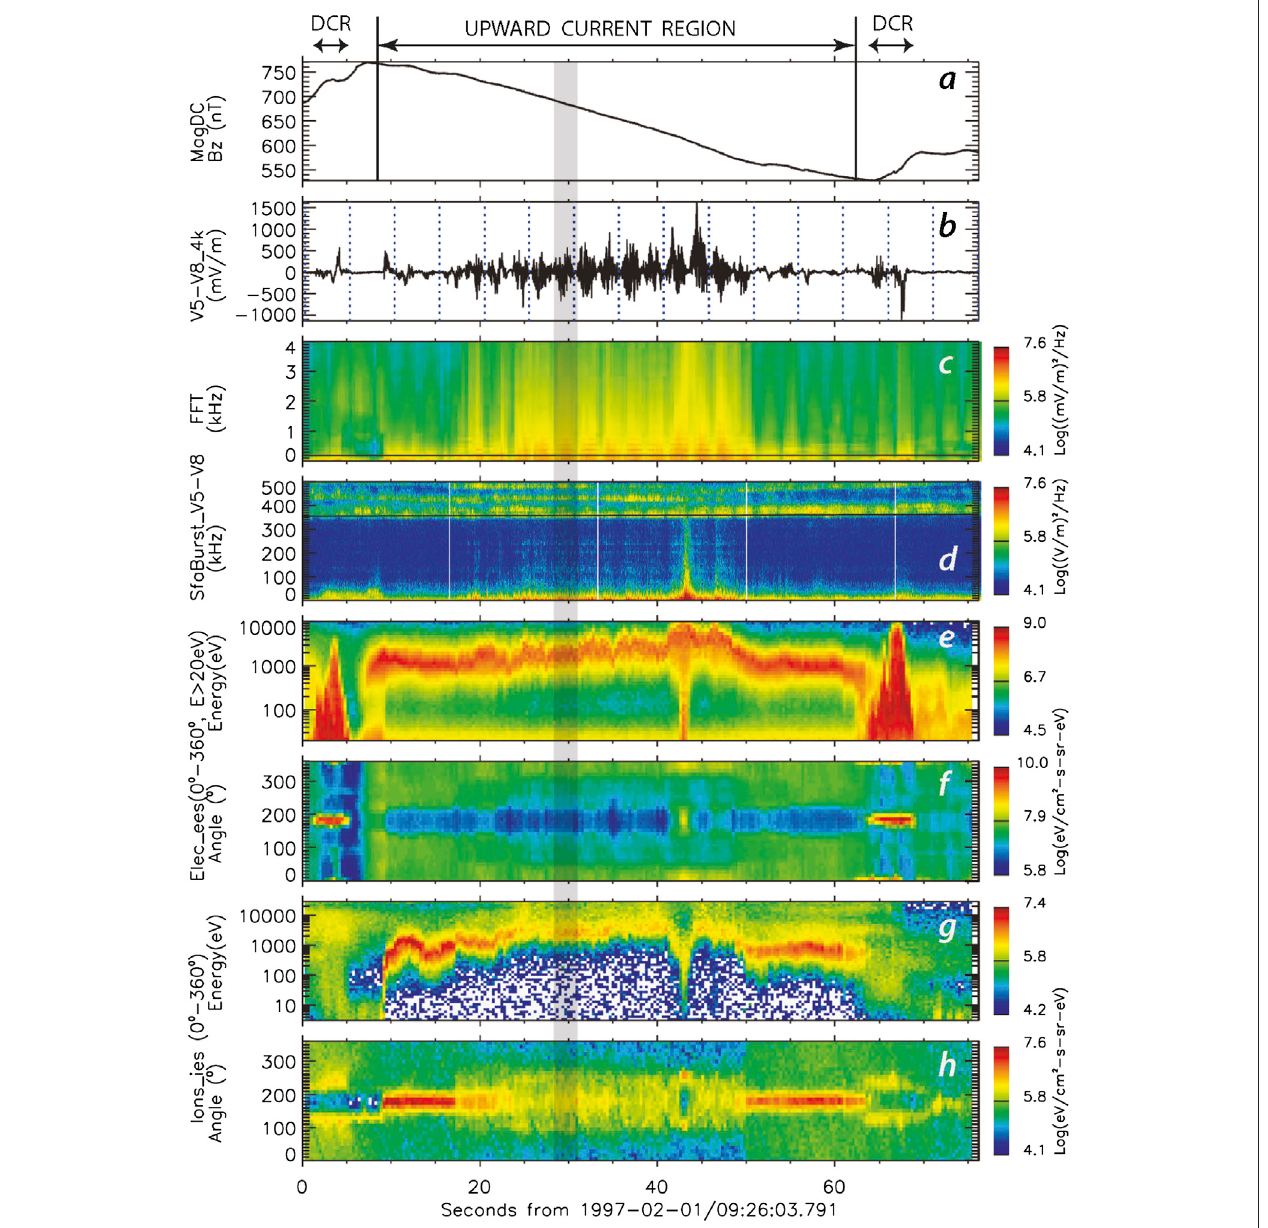
FIGURE 2 | Full sequence of FAST measurements across dow-up-auroral current system on 02-01-1997 (after [16, 17]). (A) Magnetic fi eld component b ⊥ transverse to main fi eld B 0 , (B) electric fi eld fl uctuation wave form δ E , (C) low frequency electric fl uctuation spectrum, (D) high frequency electric spectrum, showing emission of auroral kilometric radiation bands (E) electron energy spectrum, (F) electron fl ux vs. pitch-angle, (G) ion energy fl ux, (H) ion fl ux vs. pitch-angle. The most intriguingparthereisthesmoothnessofthemagneticsignatureoftheupwardcurrentinitslinearcourseshowingthattheupwardcurrentisabroadhomogeneous current sheet. The downward current region (DCR) fl anks the upward current region to both its sides, is comparably narrow in its spatial extent, and exhibits strong current and fl ux variations. This is seen in the electron fl ux panels (E,F) . Downward fl uxes around few keV are relatively smooth indicating a relatively stable tail reconnection over observation time, upward fl uxes have maximum at low energy and are highly variable in time and space. The magnetic fi eld being the integrated response to the spatial fl ux fl uctuations exhibits a much smoother course which is inverse with respect to that of the upward current thus indicating the reversed current direction. Note the low energies of the upward electron fl uxes in panel fi ve as well as the clear separation of upward and downward fl uxes as seen in the left part.